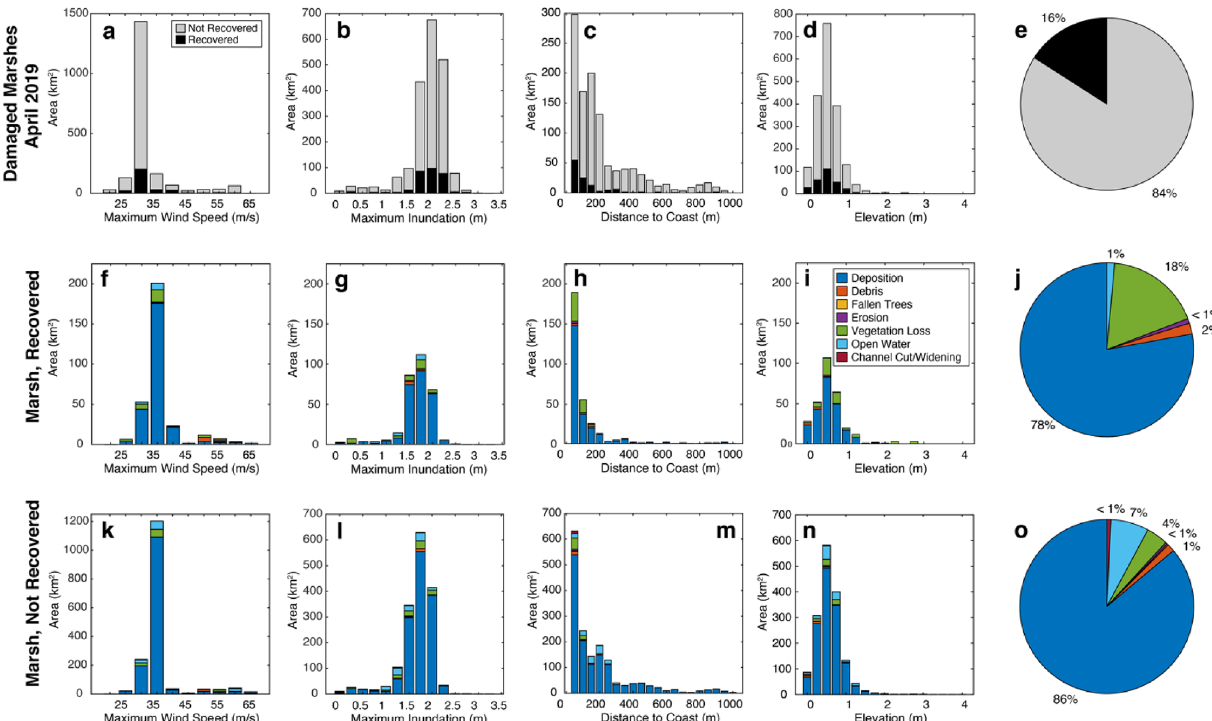
Figure 6. Analysis of recovery for damaged Panhandle marshes. Analysis is limited to marshes with aerial imagery from April 2019 (Fig. 2). ( a–d) Recovered and non-recovered marsh area as a function of maximum wind speed, maximum inundation, distance to coast, and elevation, respectively. ( e) Pie chart of ratio of recovered to non-recovered marshes. ( f–i) Original damage type of recovered marsh area as a function of maximum wind speed, maximum inundation, distance to coast, and elevation, respectively. ( j) Pie chart of distribution of original damage type of recovered marshes. ( k–n) Damage type of non-recovered marsh area as a function of maximum wind speed, maximum inundation, distance to coast, and elevation, respectively. ( o) Pie chart of distribution of damage type of non-recovered